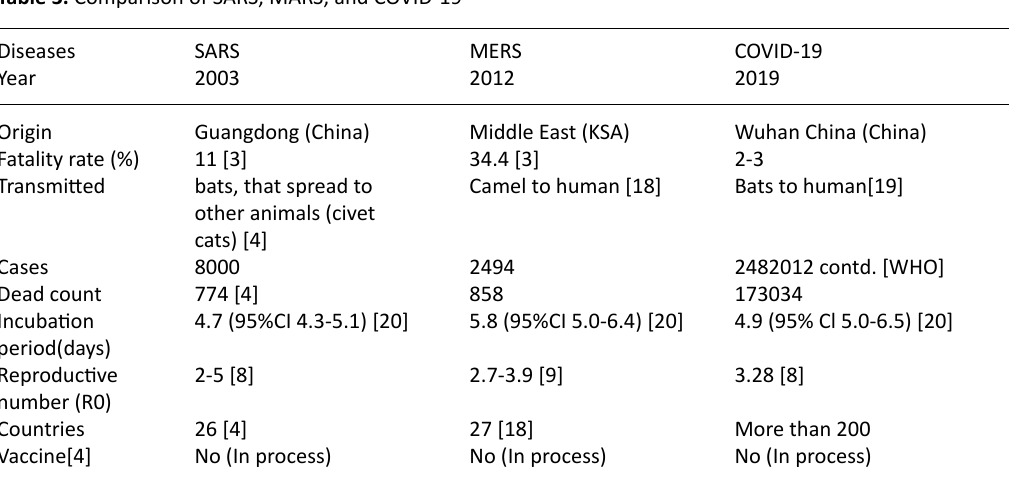
Table 3. Comparison of SARS, MARS, and COVID-19 Diseases